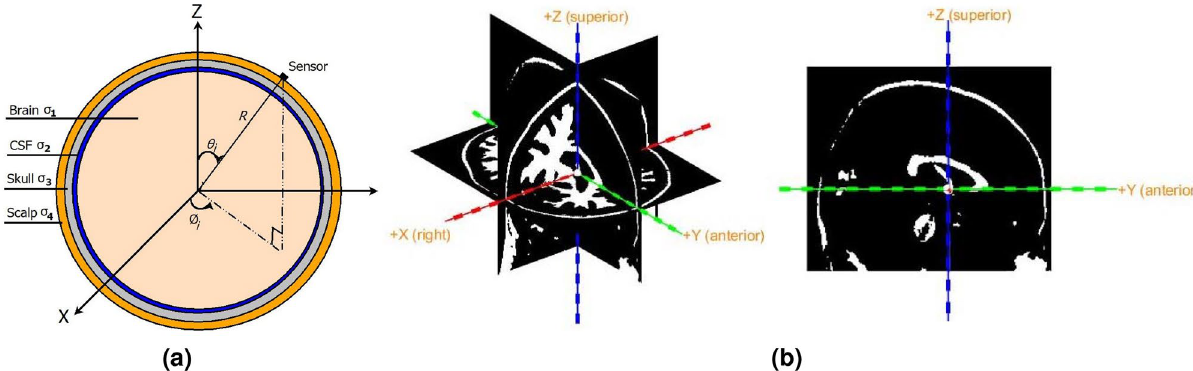
Figure 1. ( a ) Four shell head model, and ( b ) coordinate